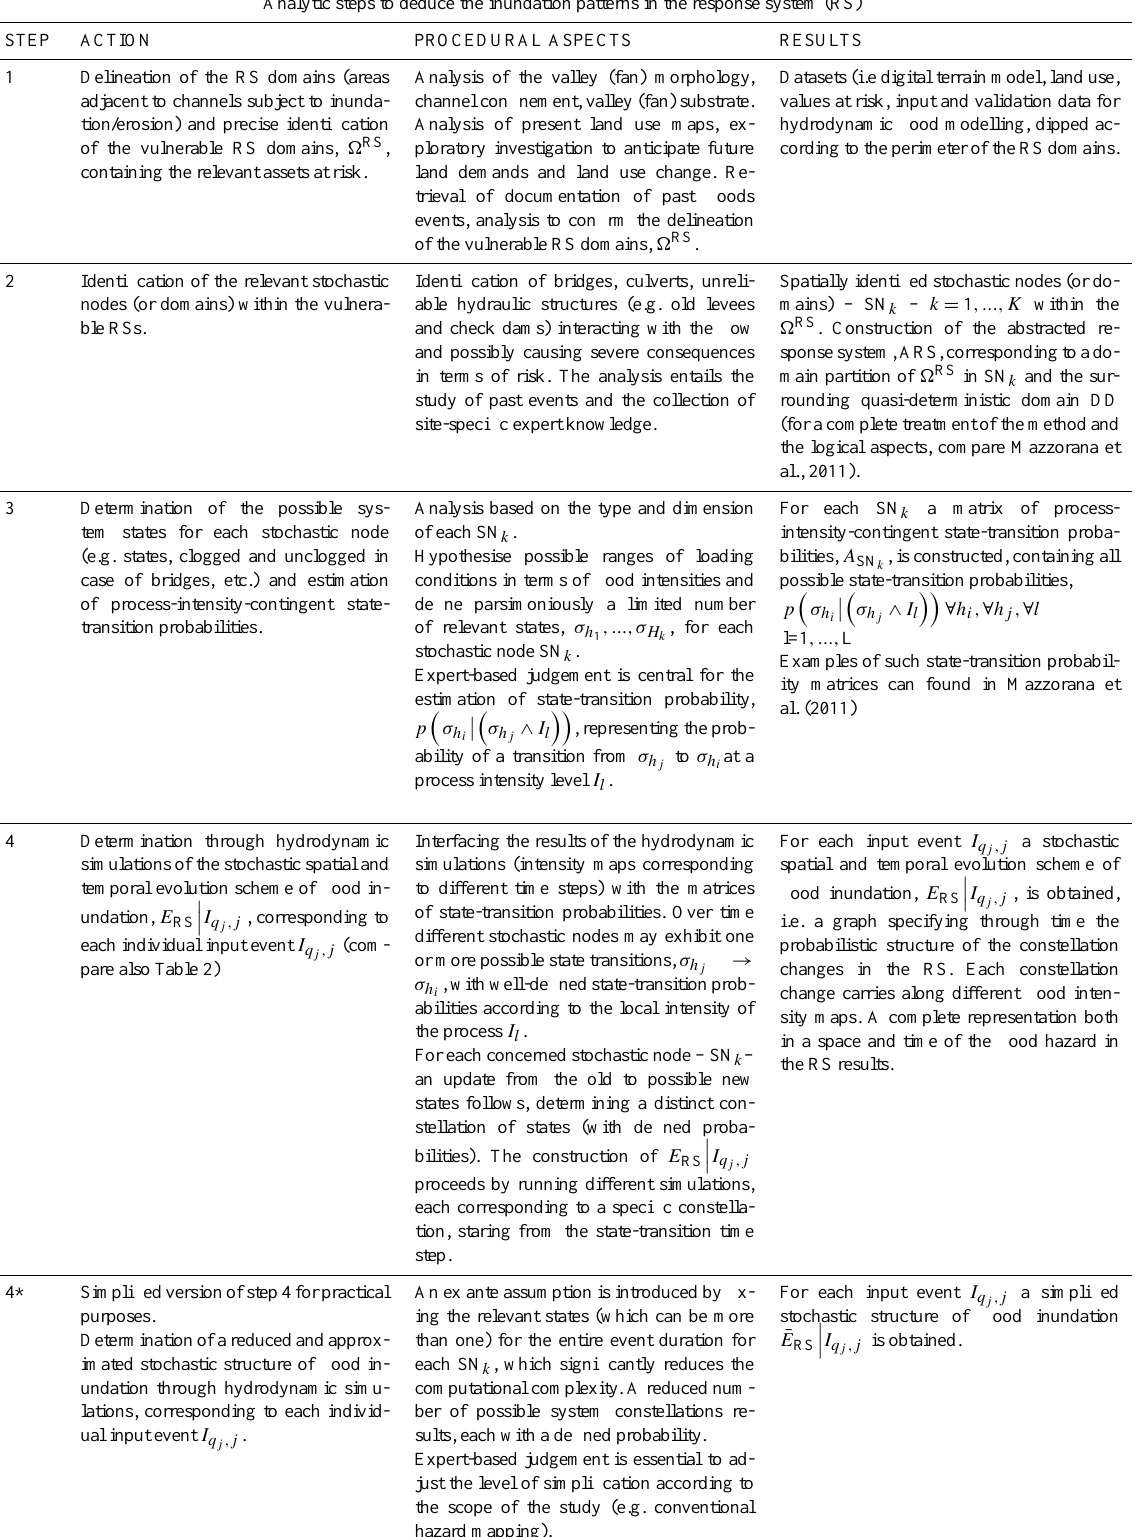
Table 3. Main process analysis steps in the response system